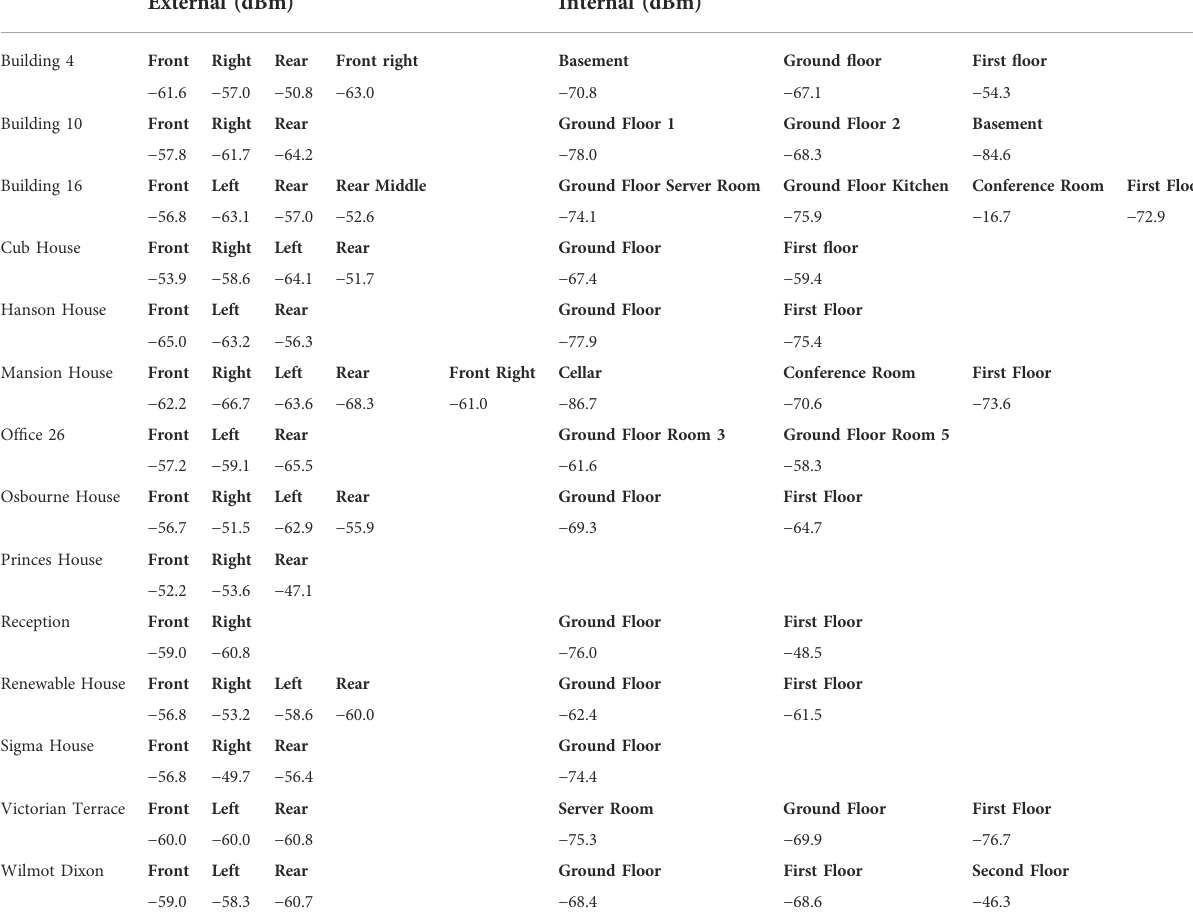
TABLE 1 Results from the measurements made outside and inside the building at the BRE at 900